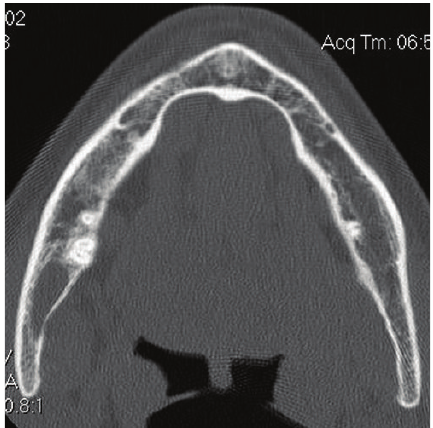
Figure 2: Tc axial scan revealed a well circumscribed unilocular image involving the mandibular ramus.